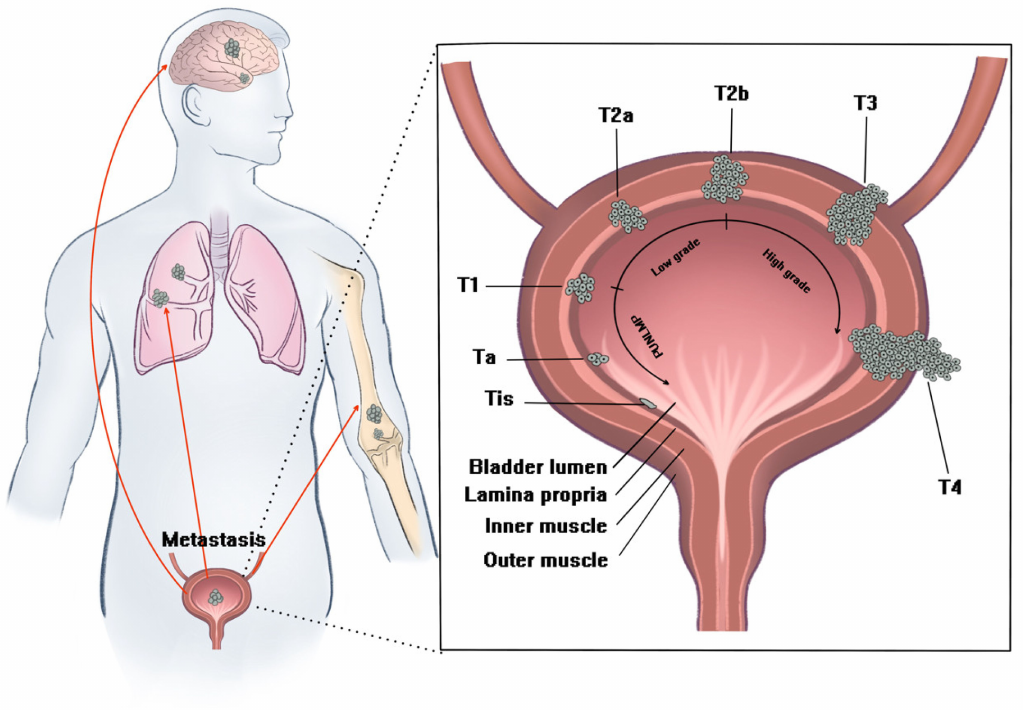
Figure 1. The stage and grade of bladder cancer. Bladder cancer is divided into five stages according to the degree of progression: T0 (Ta: non-invasive papilla-carcinoma and Tis: tumor in situ); T1 (Tumor invades the bladder mucosa); T2 (Tumor invades the bladder inner muscle); T3 (Tumor invades the bladder outer muscle); and T4 (Tumor metastasis). Non-muscle-invasive bladder cancer (NMIBC) refers to T0 and T1 stages, while muscle-invasive bladder cancer (MIBC) refers to ≥ T2